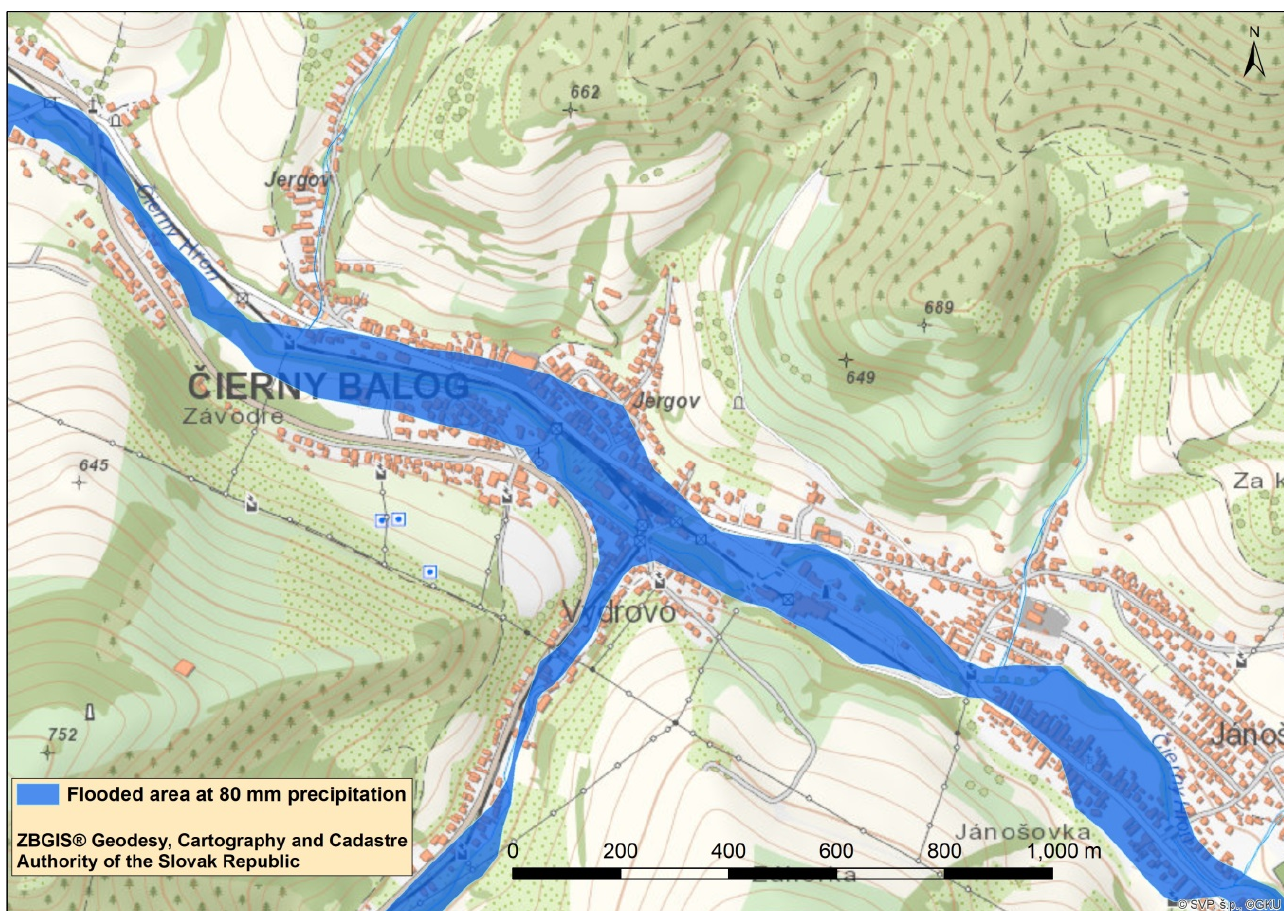
Figure 2. Extent of the modelled flooded area with the current land use and precipitation 80 mm/day in the HEC-RAS model.